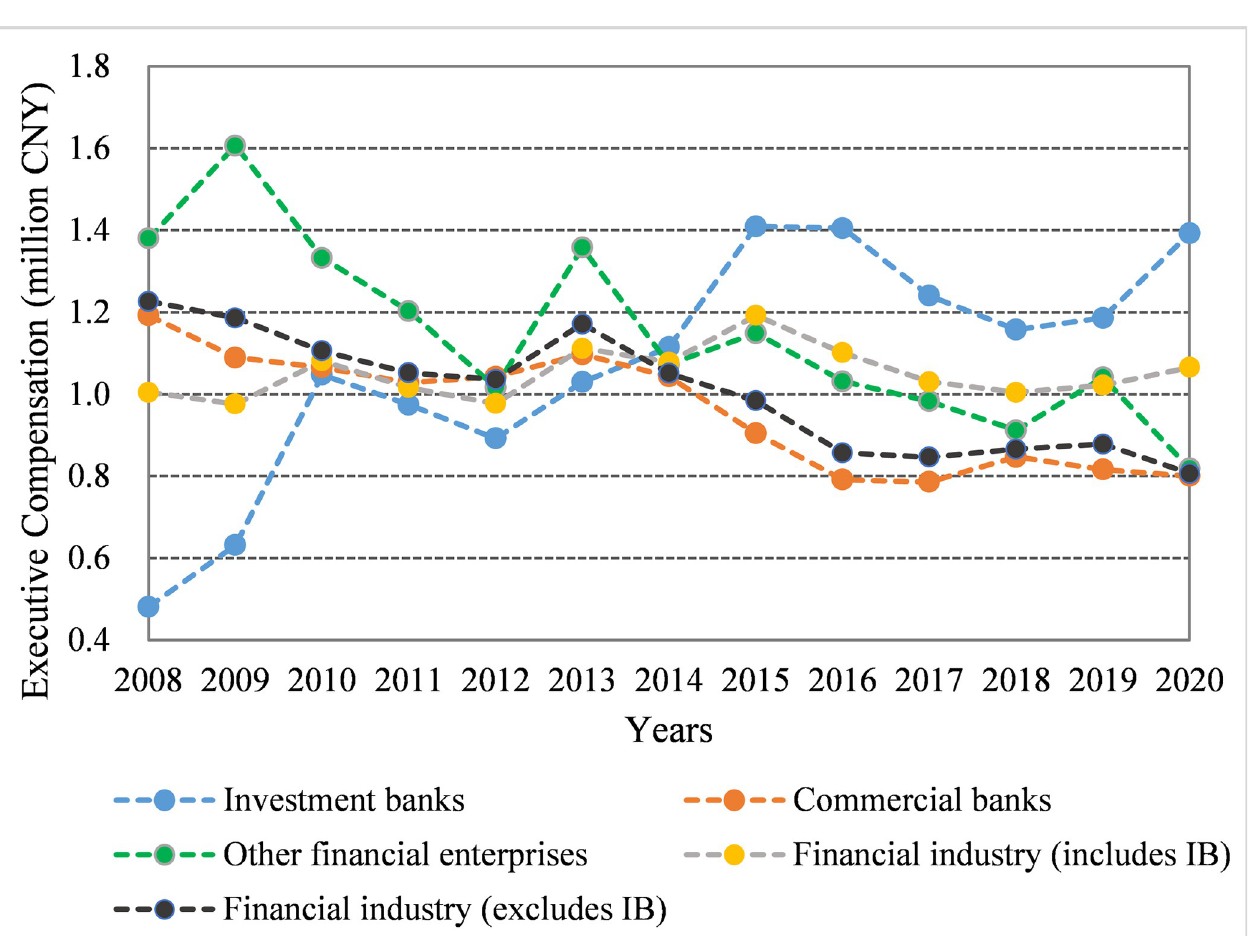
Fig 2. The average monetary compensation of executives in the Chinese financial